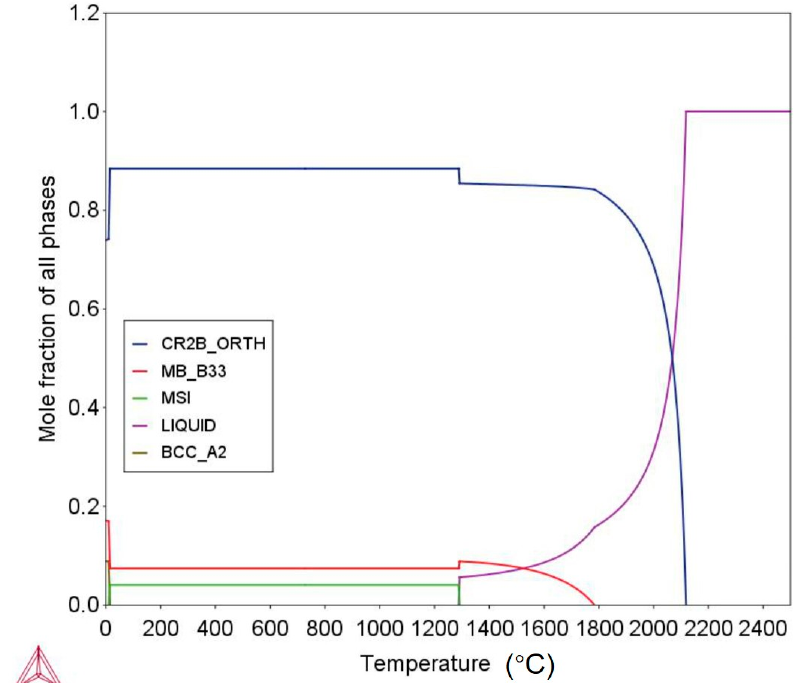
Figure 1. THERMOCALC calculations of the phase equilibrium for the alloy used in the current study.